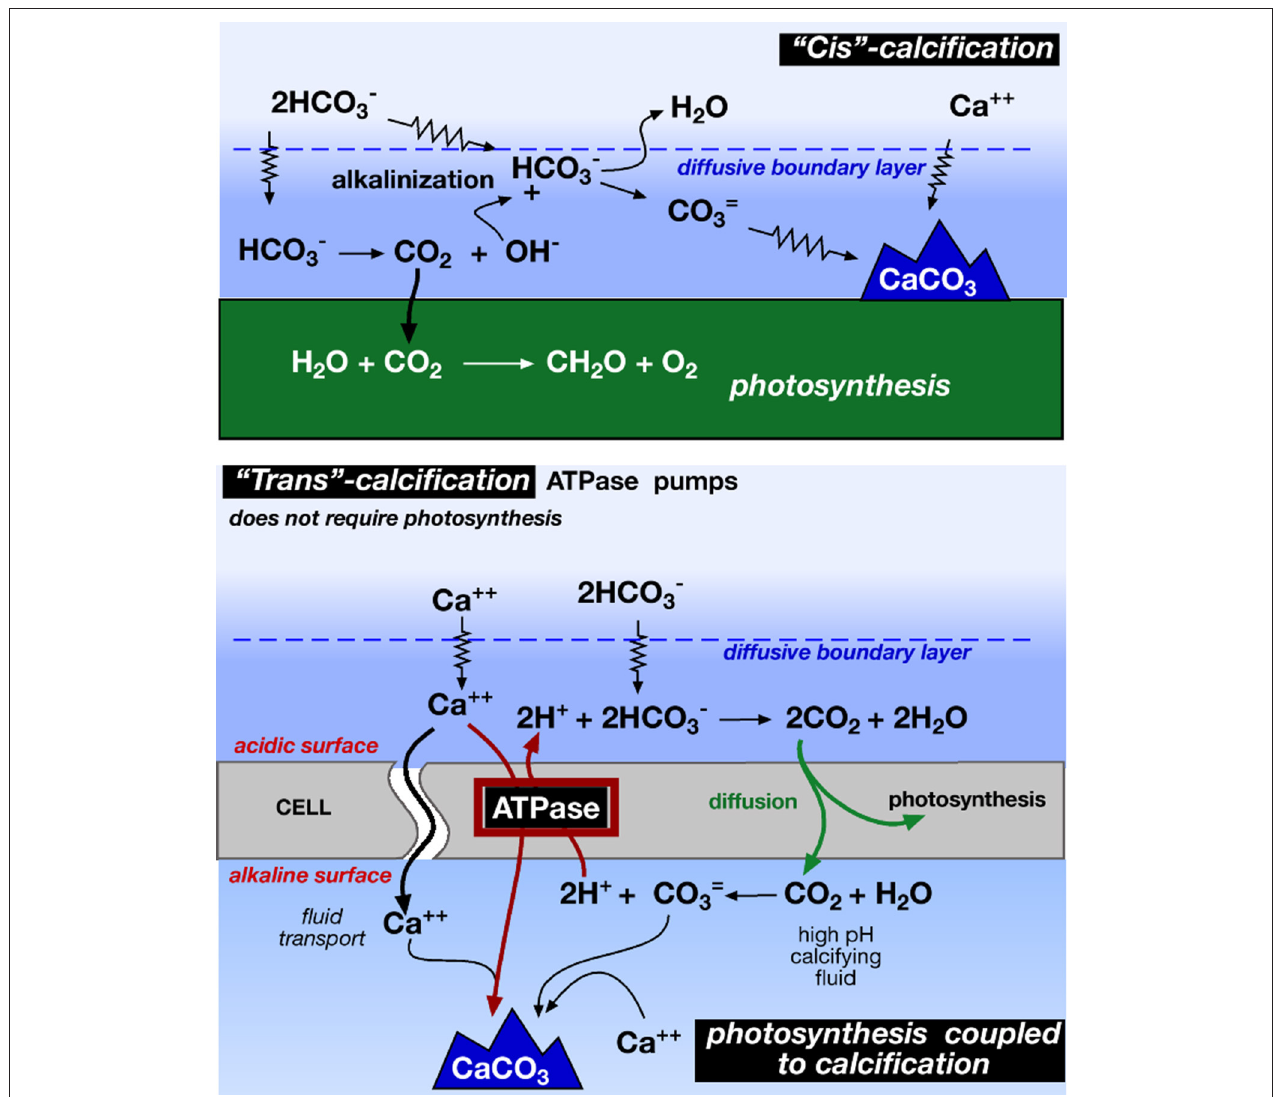
FIGURE 1 | “ Cis ” and “ trans ” calcification mechanisms. Photosynthetic alcalinization of the water causes cis calcification, while enzyme Ca ++ ATPase drives the Ca ++ /2H + exchange in the trans calcification (redrawn from McConnaughey and Whelan, 1997). Cis calcification occurs on the same side of the photosynthetic carbon uptake, whereas trans calcification occurs away of the site of carbon